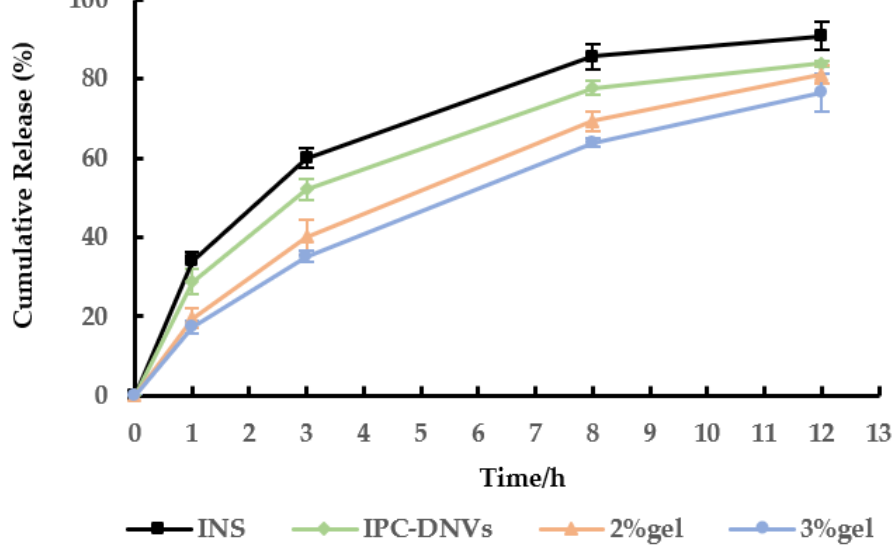
Figure 2. In vitro release of IPC-DNV gels with differing gelatin content. INS, insulin solution.